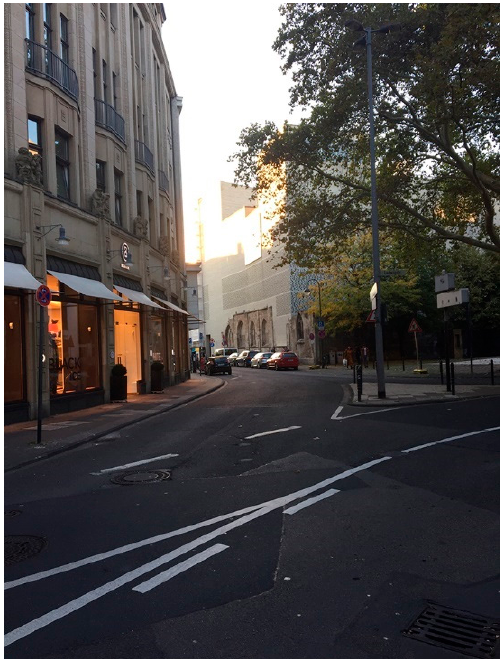
Figure 1. View of a fragment of the “Kolumba” museum’s facade and of the historical townhouse at 17 Brückenstra β e and the square with greenery near the intersection of Brückenstra β e and Ludwigstra β e in Cologne, Germany (image 1).